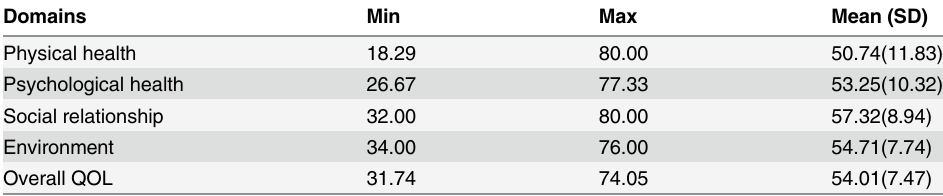
Table 4. Quality of life (QOL) domain scores among the study